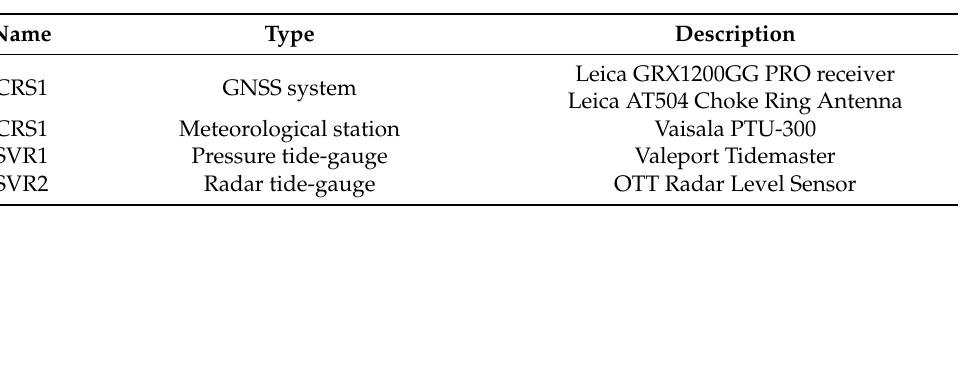
Table 1. Main instrument characteristics at the CRS1 sea-surface Cal/Val